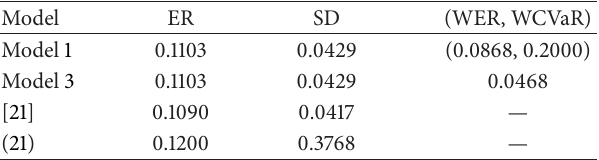
Table 1: Numerical results for Example 1 ( 𝜎 1 = 𝜎 3 = 0.2 ).